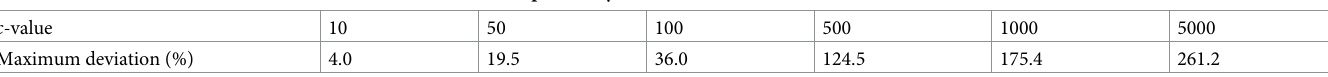
Table 1. The maximum deviation of SDR with different c -values predict by ITC measurement model and variance function. c